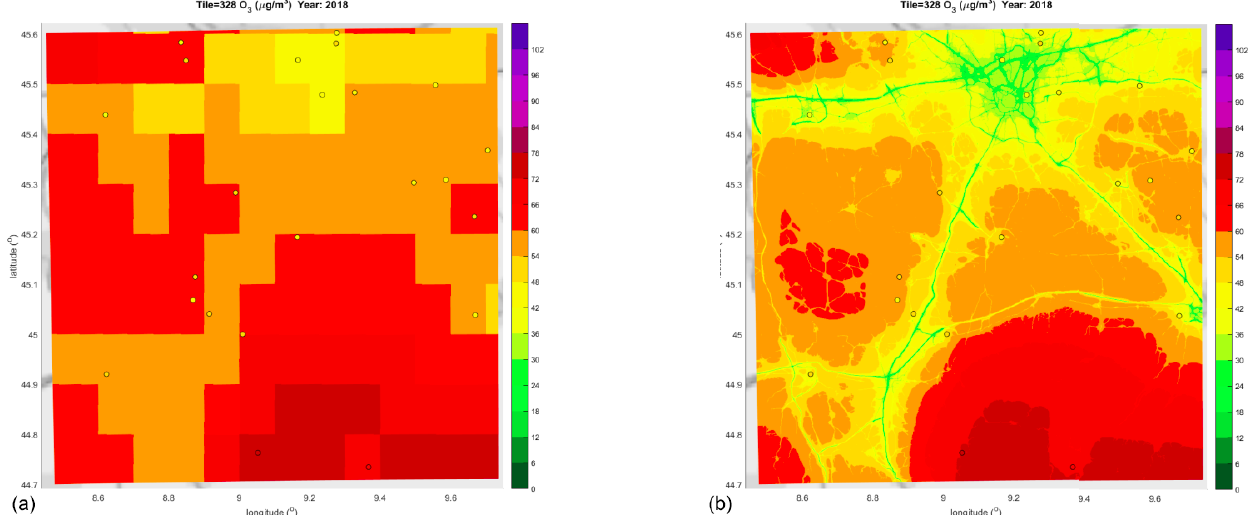
Figure 5. Calculated O 3 concentrations in the 100km tile (no. 328) for 2018, which is part of the all European calculation at 100m resolution. (a) The EMEP model calculation at 0.1 ◦ and (b) the uEMEP calculation at 100m resolution. The city in this tile is Milan. AIRBASE stations are shown as circles. This is the same tile shown in Fig.